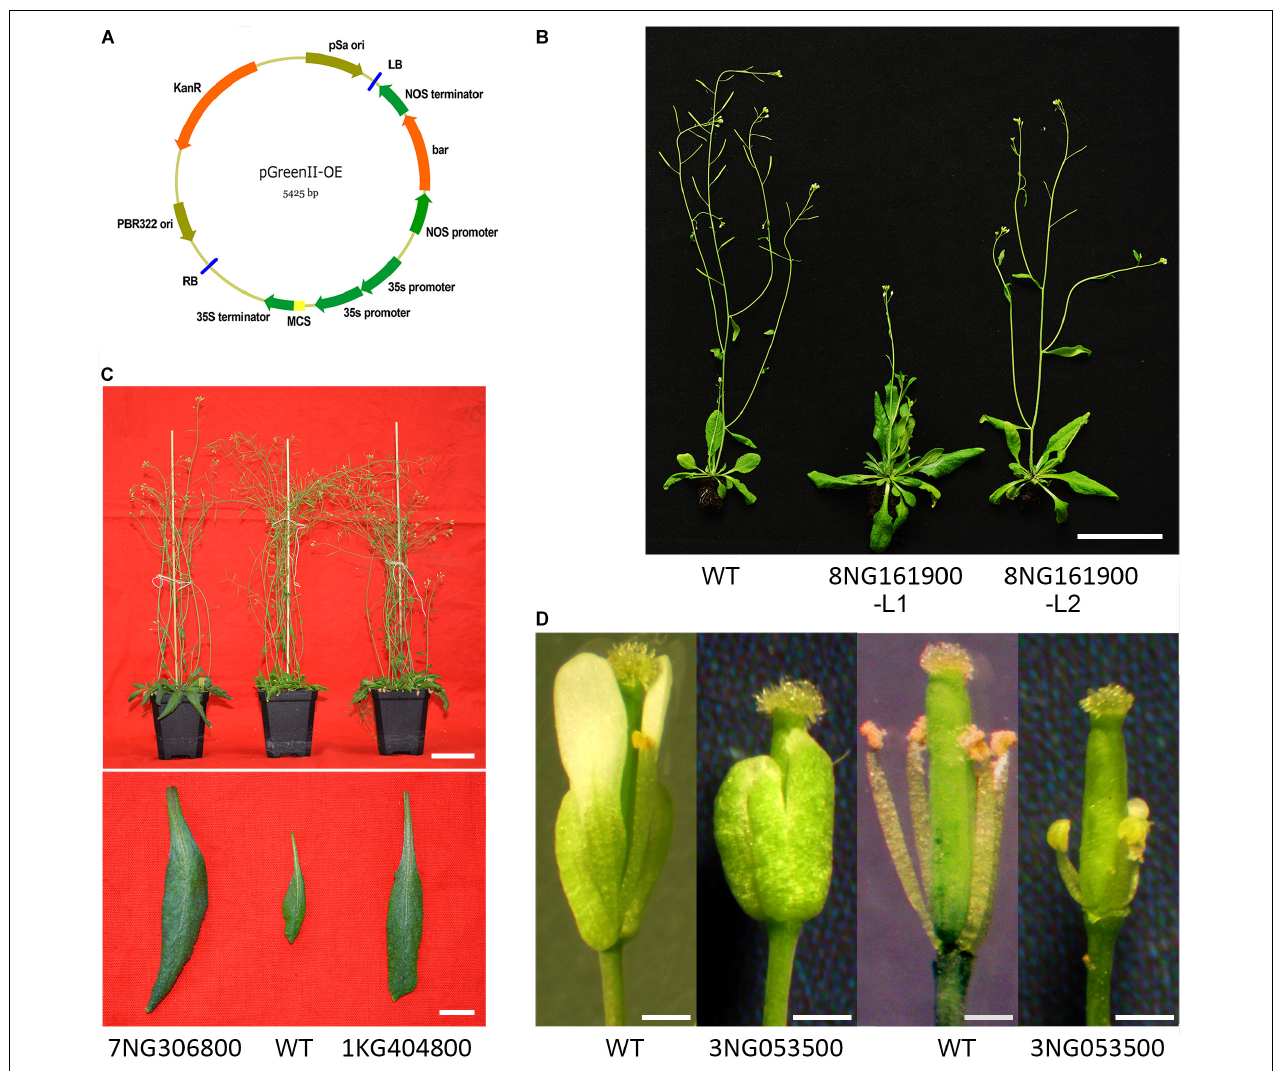
FIGURE 6 | Investigation of the gene function of filtered-DEGs. (A) Expression vector employed. (B) Transgenic Pavir.8NG161900 plants compared with wild-type Arabidopsis . (C) Transgenic Pavir.7NG306800 and Pavir.1KG404800 plants compared with wild-type Arabidopsis . (D) Flowers of transgenic plants of Pavir.3NG053500 compared with wild-type Arabidopsis